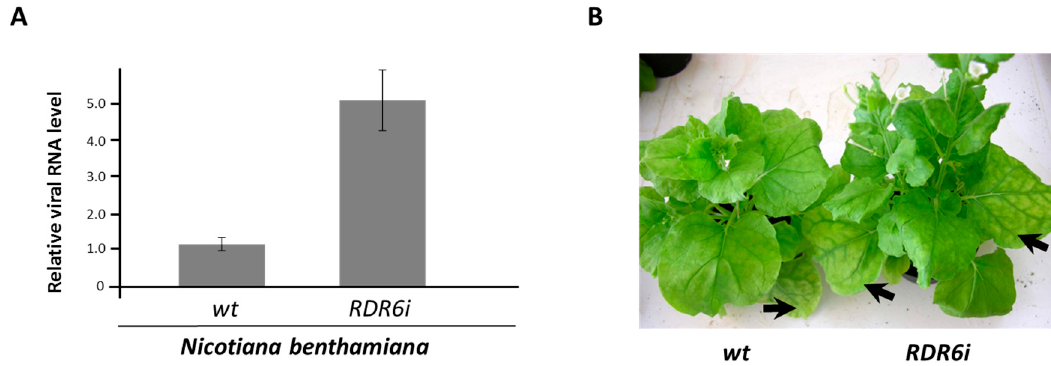
Figure 1. Enhanced susceptibility to Tomato chlorosis virus (ToCV) transmitted using its natural vector Bemisia tabaci in Nicotiana benthamiana RDR6i plants at 25 days post-infiltration. ( A ) Quantitative real-time RT-PCR of ToCV RNA2 in infected N. benthamiana wild-type and RDR6i plants performed using pools of three plants each. Error bars represent standard deviation for three replicates. Values are relative to levels detected in wild-type plants, which were given an arbitrary value of 1; ( B ) Interveinal chlorotic symptoms of ToCV in infected N. benthamiana wild-type and RDR6i plants. Leaves exhibiting enhanced interveinal symptoms are indicated by arrows.